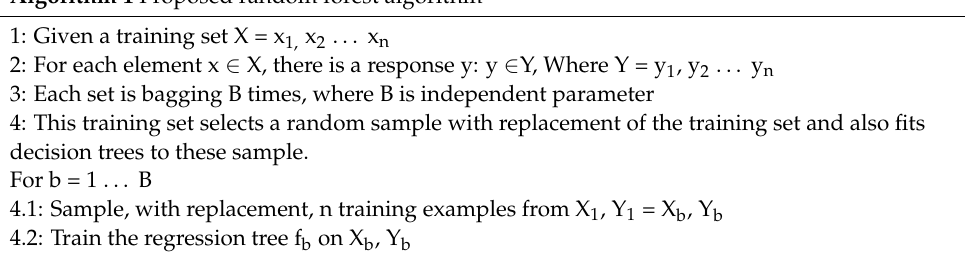
Figure 2. Architecture of the assimilation of IoT and ML for WQIs. Algorithm 1 Proposed random forest algorithm